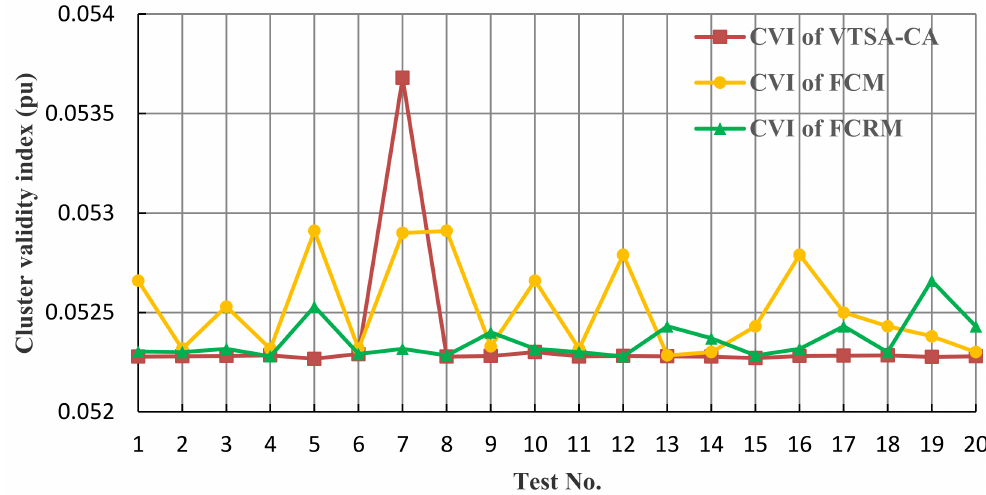
Figure 10. The comparison of the CVI values in 20 experiments.